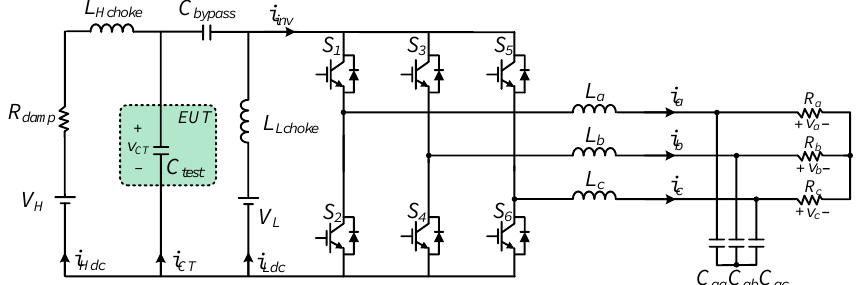
Figure 2. Down-scale voltage rating evaluation system in a high-power three-phase inverter